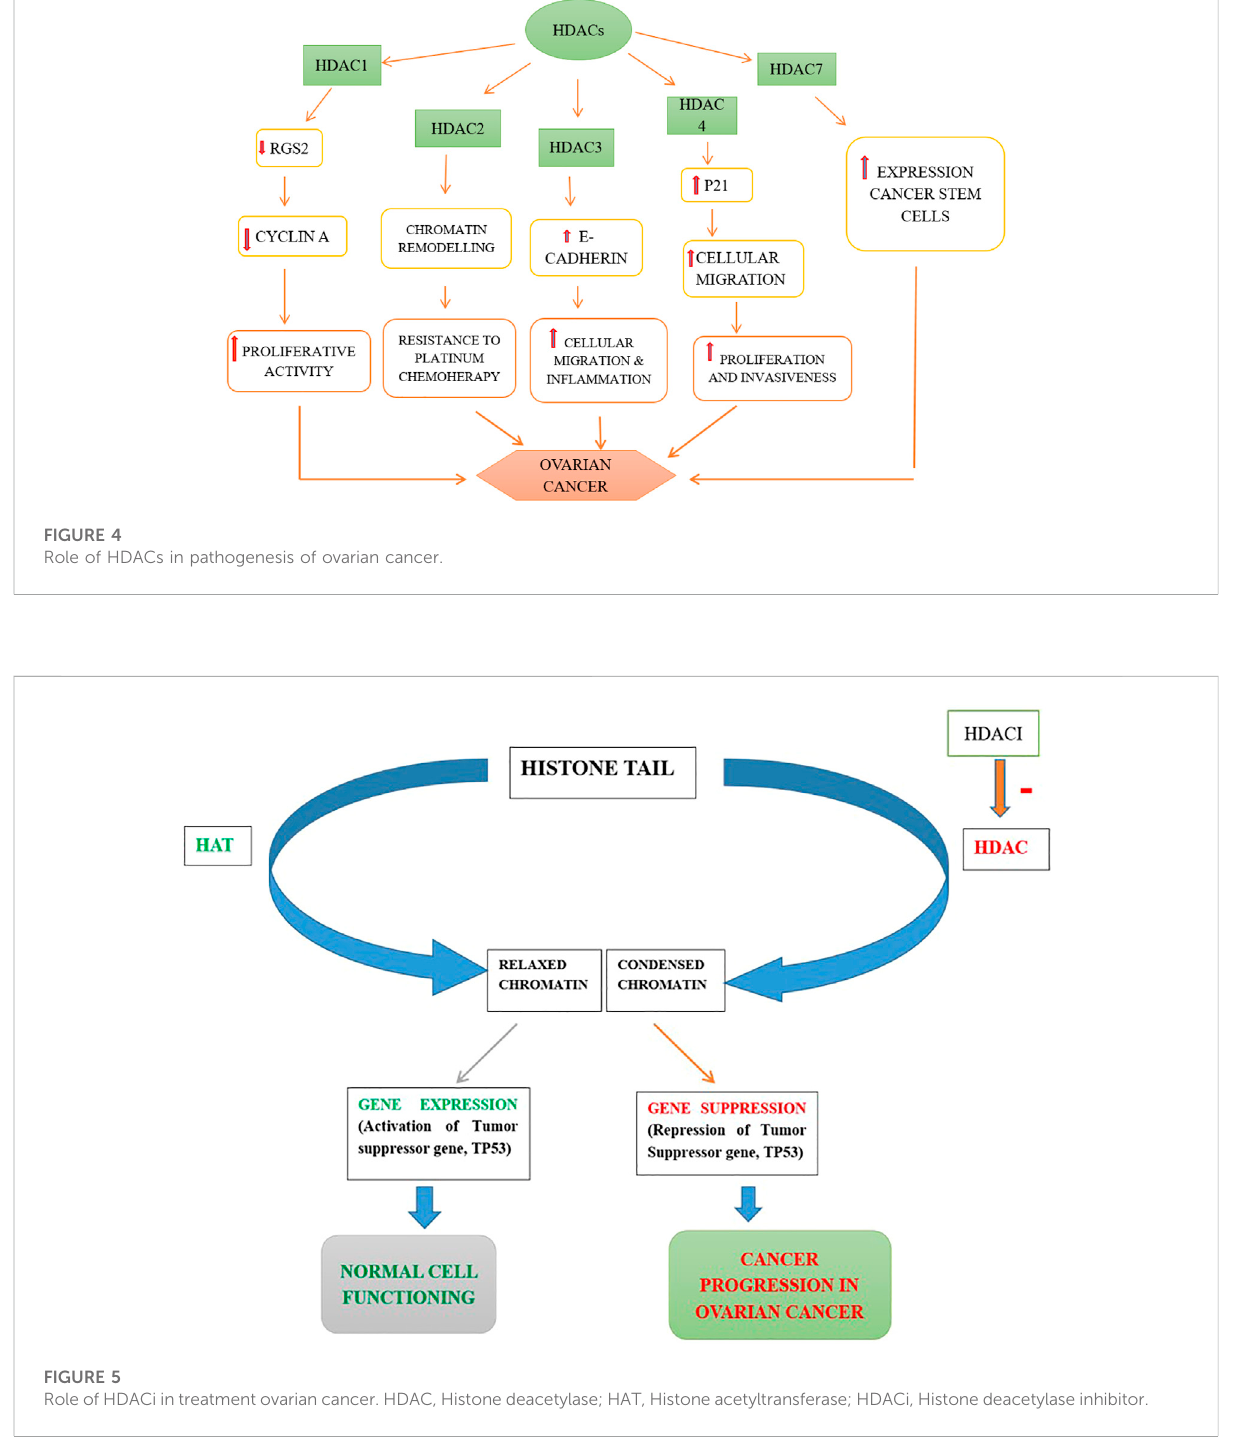
(VEGF protein competitor) expression, at both mRNA and protein levels (Takai and Narahara, 2010). Whereas, valproic acid (VPA), owing to its anti-angiogenic property, induces down